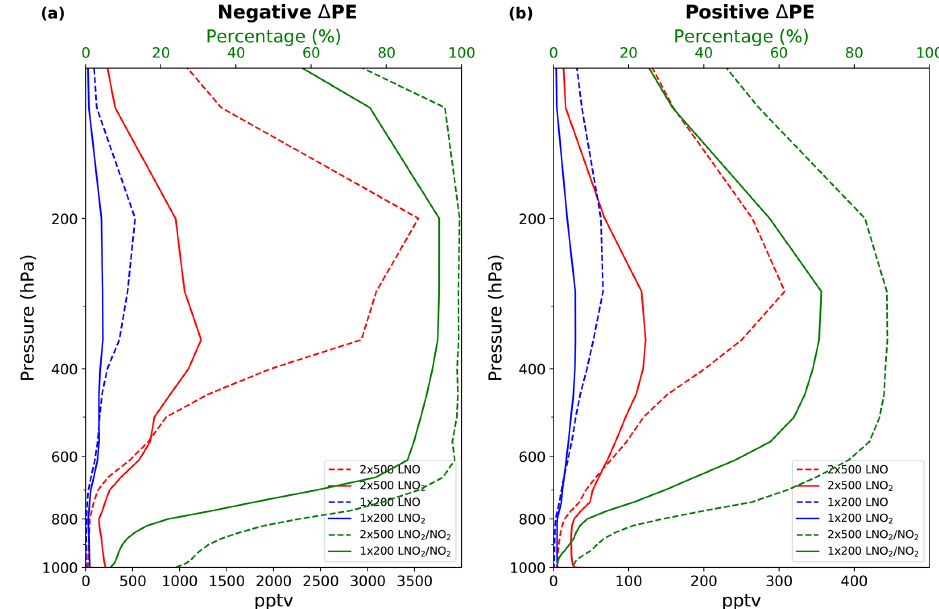
Figure 11. LNO and LNO 2 profiles with different LNO settings in (a) the region containing the minimal negative percent change in LNO 2 and (b) the region containing the largest positive percent change in LNO 2 when the LNO setting is changed from 1 × 200 to 2 × 500molNO per flash, averaged over MJJA 2014. The profiles using 1 × 200 (2 × 500)molNO per flash are shown in blue (red) lines. Solid (dashed) green lines are the mean ratio of LNO 2 to NO 2 with 1 × 200 (2 × 500)molNO per